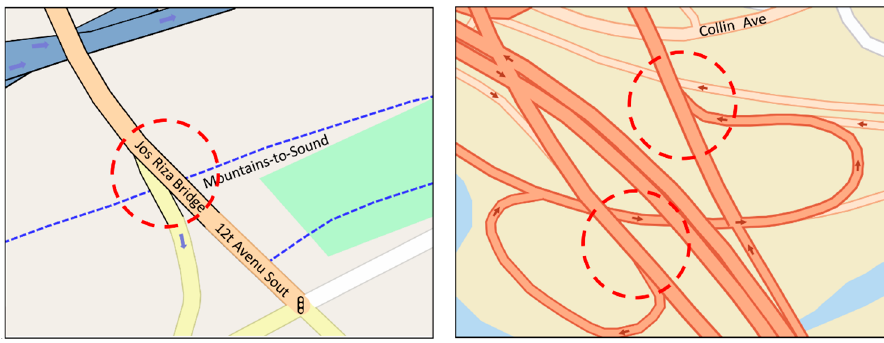
Figure 2. Typical drawing errors of road networks in a map.